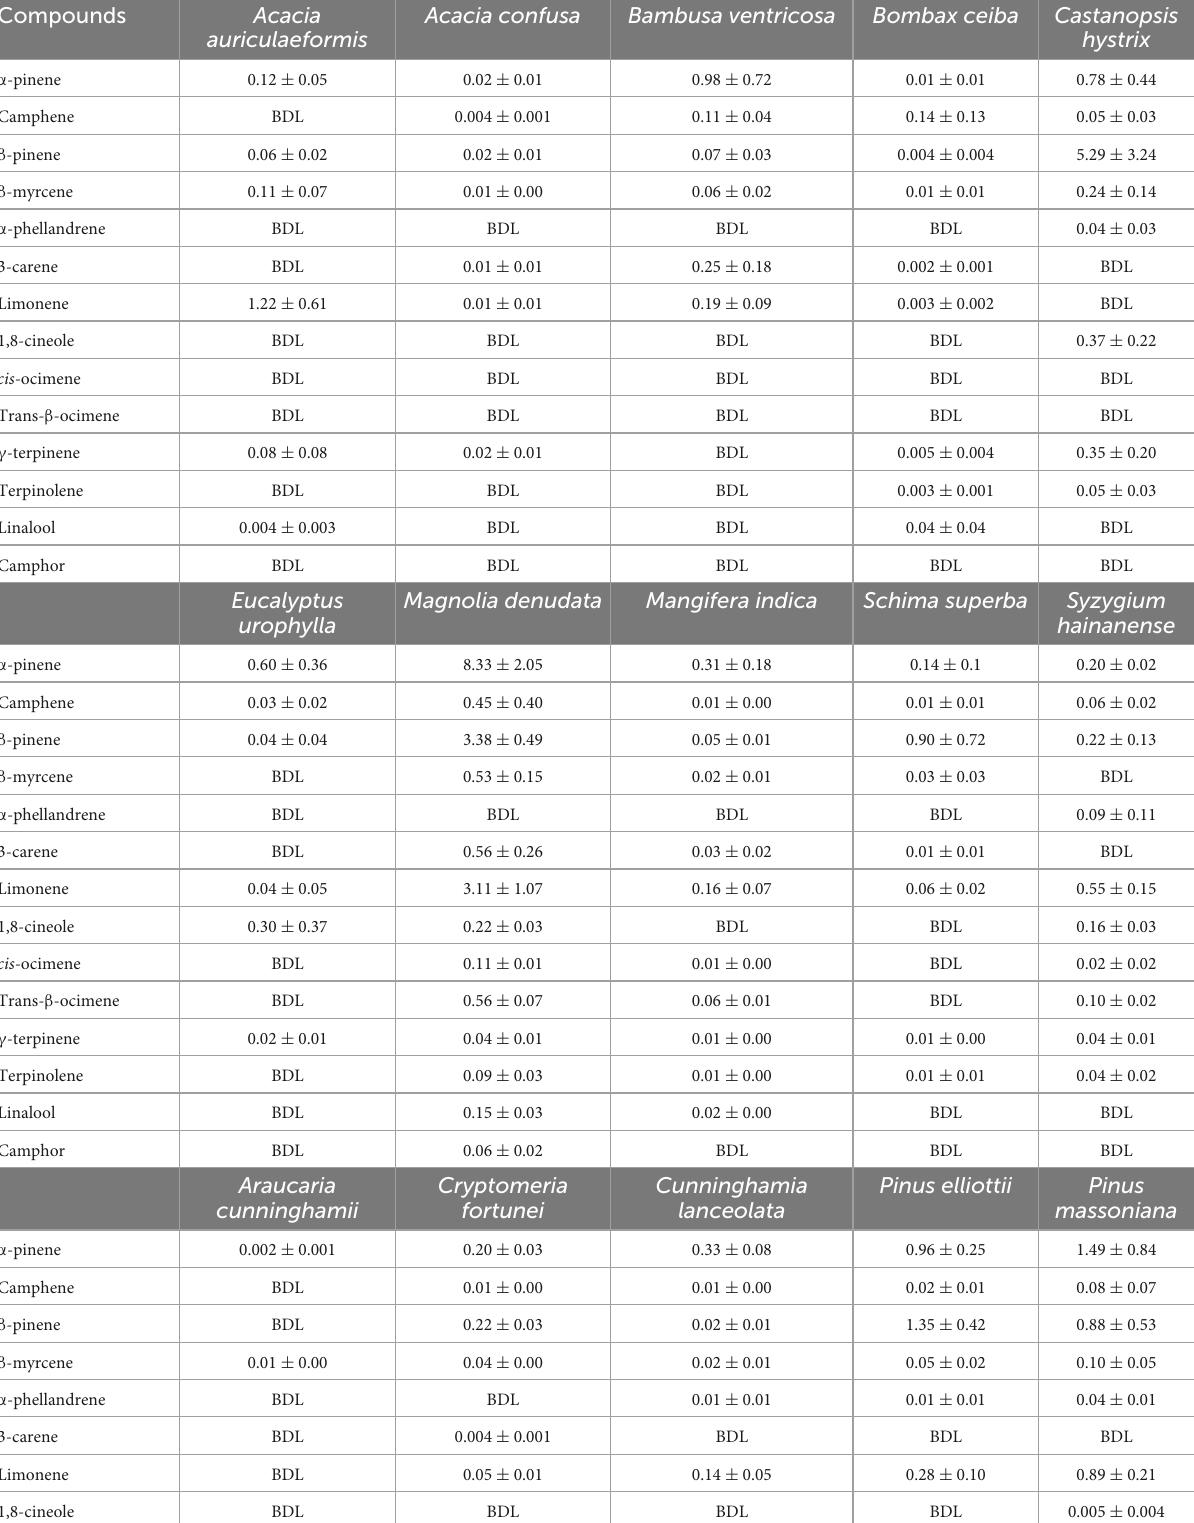
TABLE 3 Emission factors ( µ g g − 1 h − 1 ) of different monoterpene (MT) species emitted from the measured trees. Compounds Acacia Acacia auriculaeformis